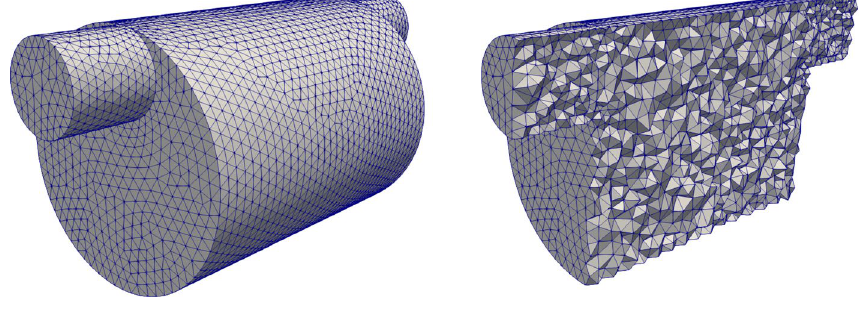
Fig. 5 Fine mesh, left: the outer surface, right: cut in the middle along the elements for the sake of